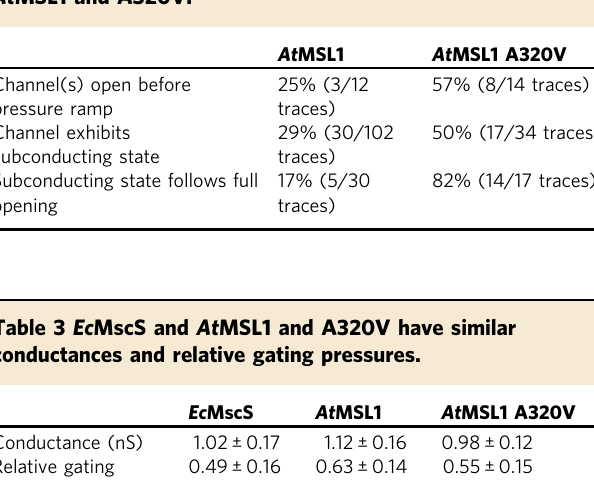
Table 2 Spontaneous opening and subconducting states for At MSL1 and A320V.